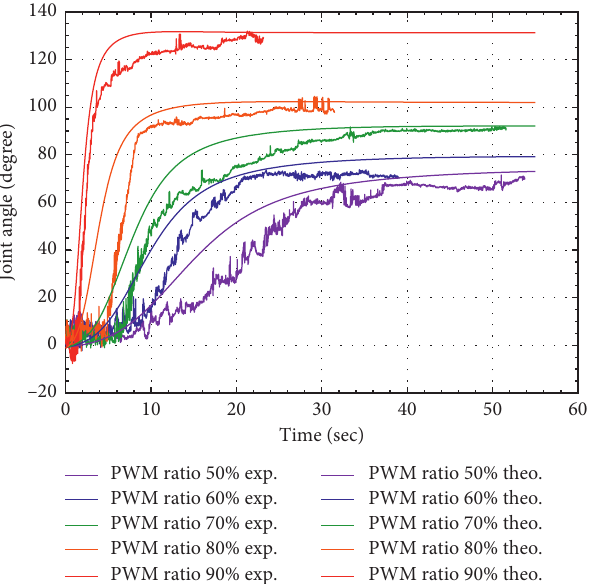
Figure 16: Total joint angle under different PWM ratio.